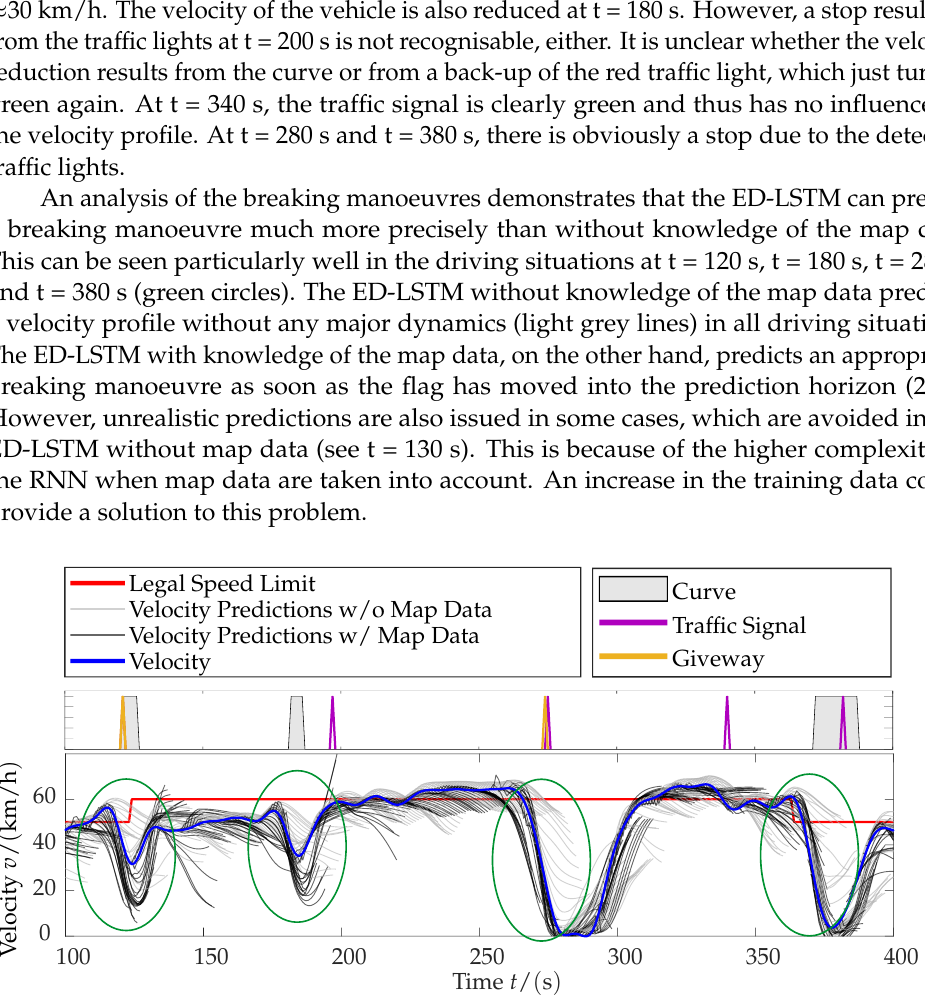
Figure 13. First exemplary test sequence using ED-LSTM 20 s prediction horizon